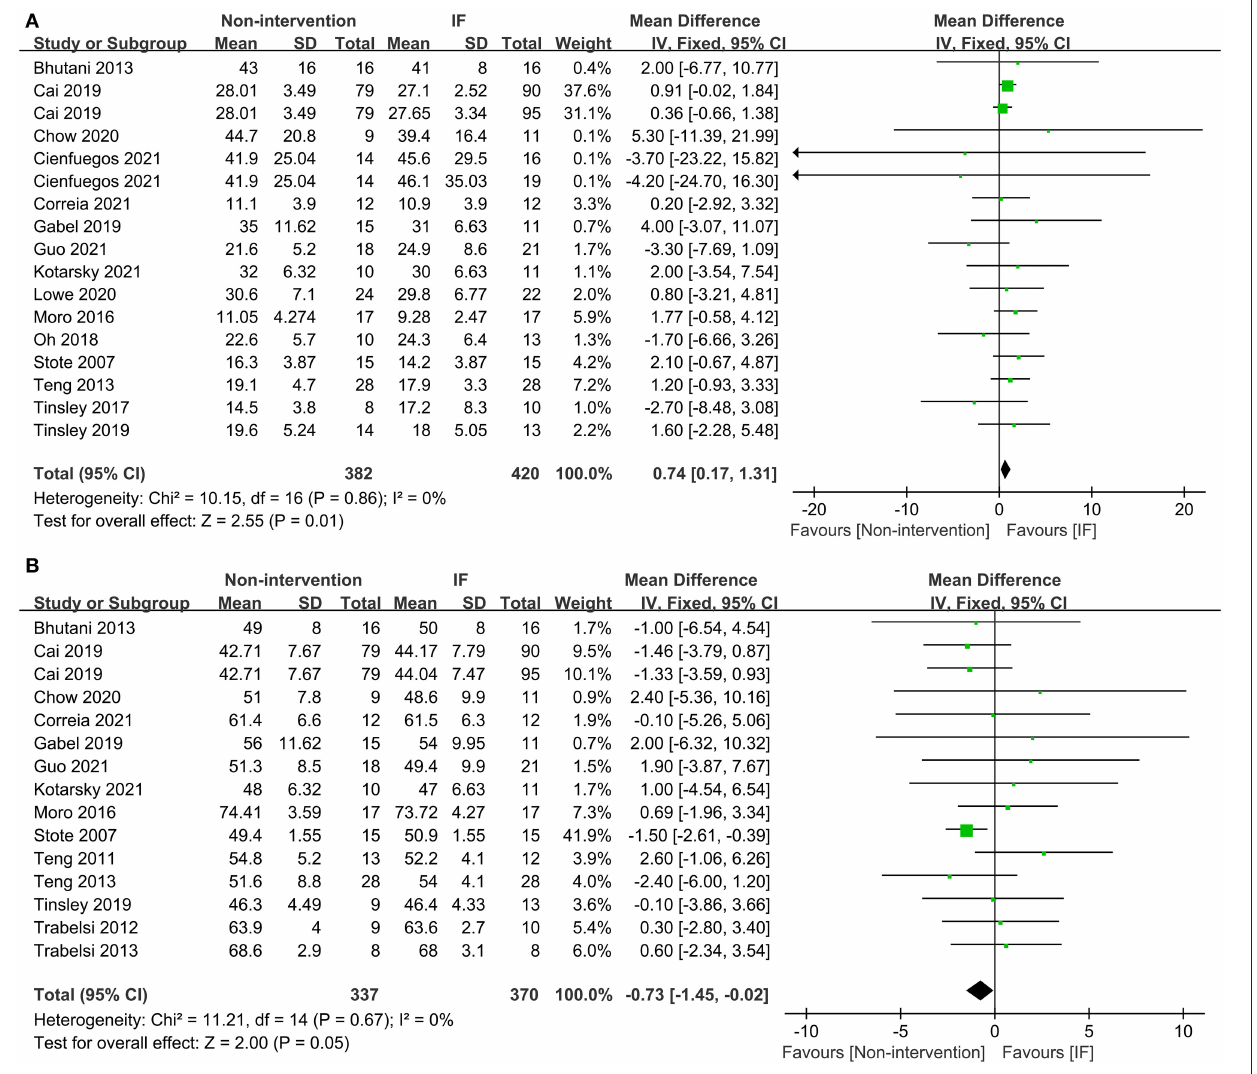
FIGURE 3 | Forest plots for the fat mass (FM) and fat-free mass (FFM) of the IF vs. non-intervention diet. (A) FM; (B)